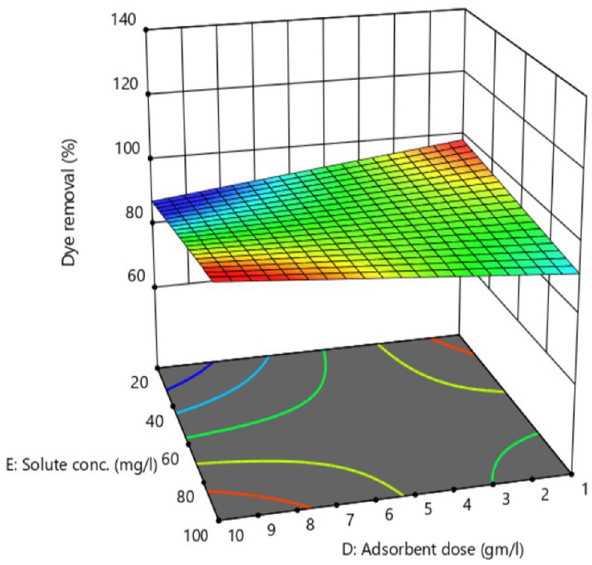
Fig. 22 Surface view showing the relation relative variation of per- centage dye removal with solute concentration and adsorbent dose